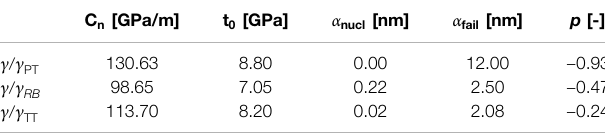
TABLE 3 | Parameters of cohesive zone model for Type-1 interface models determined from fi tting the results of MD simulations at T (cid:2) 900 K C n [GPa/m]